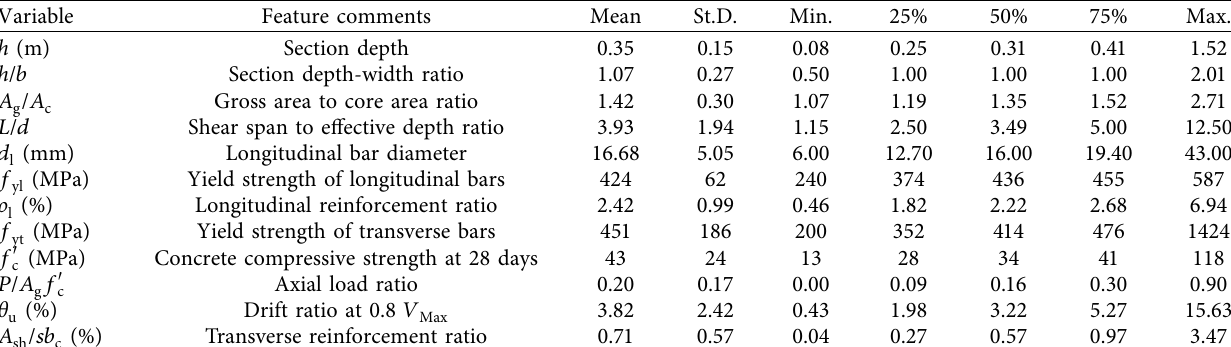
Figure 2: Estimation of drift ratio θ Table 1: Statistics summary of input and output variables.